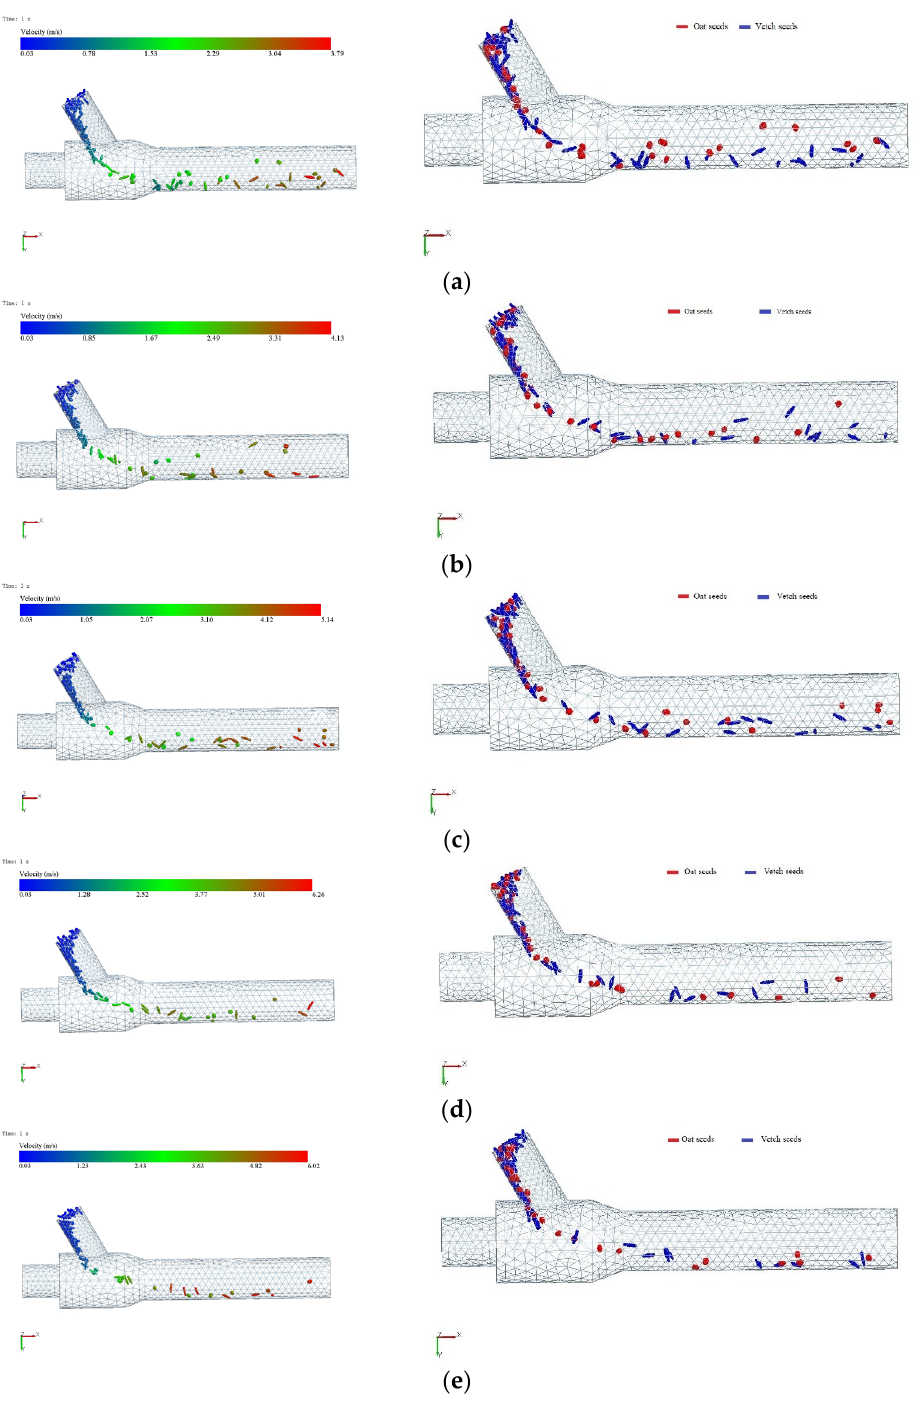
Figure 9. Five motion states in venturi tube under different inlet gas velocities: ( a ) 30 m/s.; ( b ) 35 m/s; ( c ) 40 m/s; ( d ) 45 m/s; ( e ) 50 m/s.